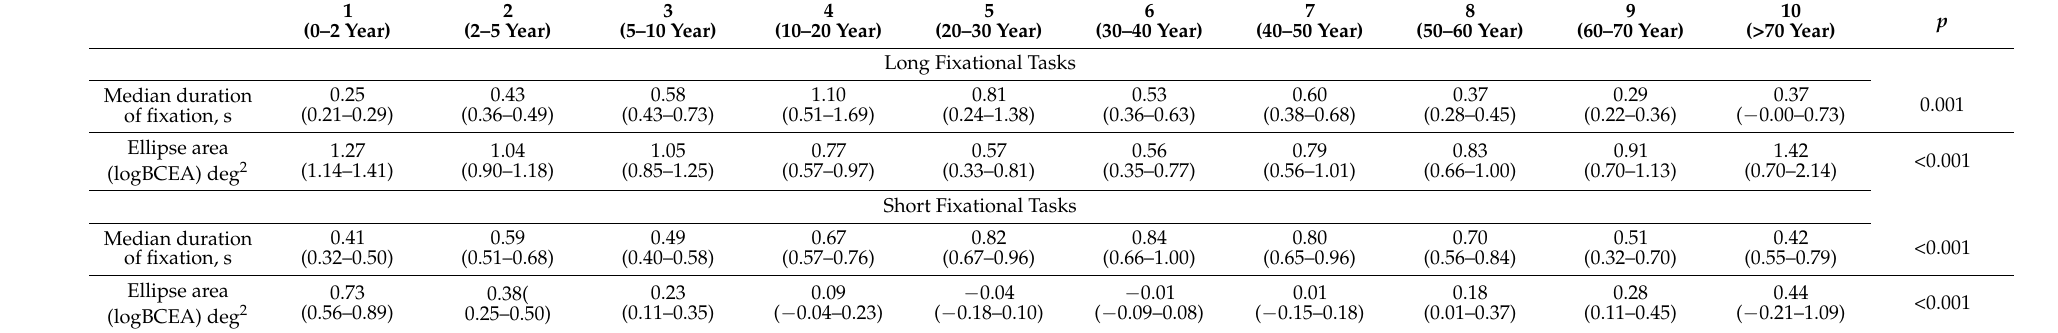
Table 2. Comparison of fixational parameters among the study groups. Data are reported as mean (95% confidence